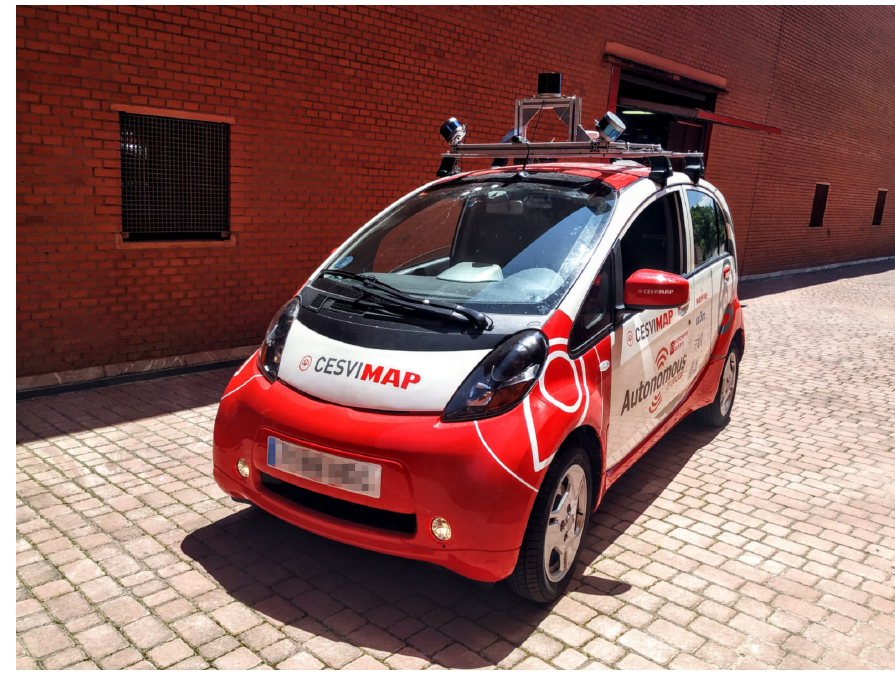
Figure 1. Autonomous vehicle